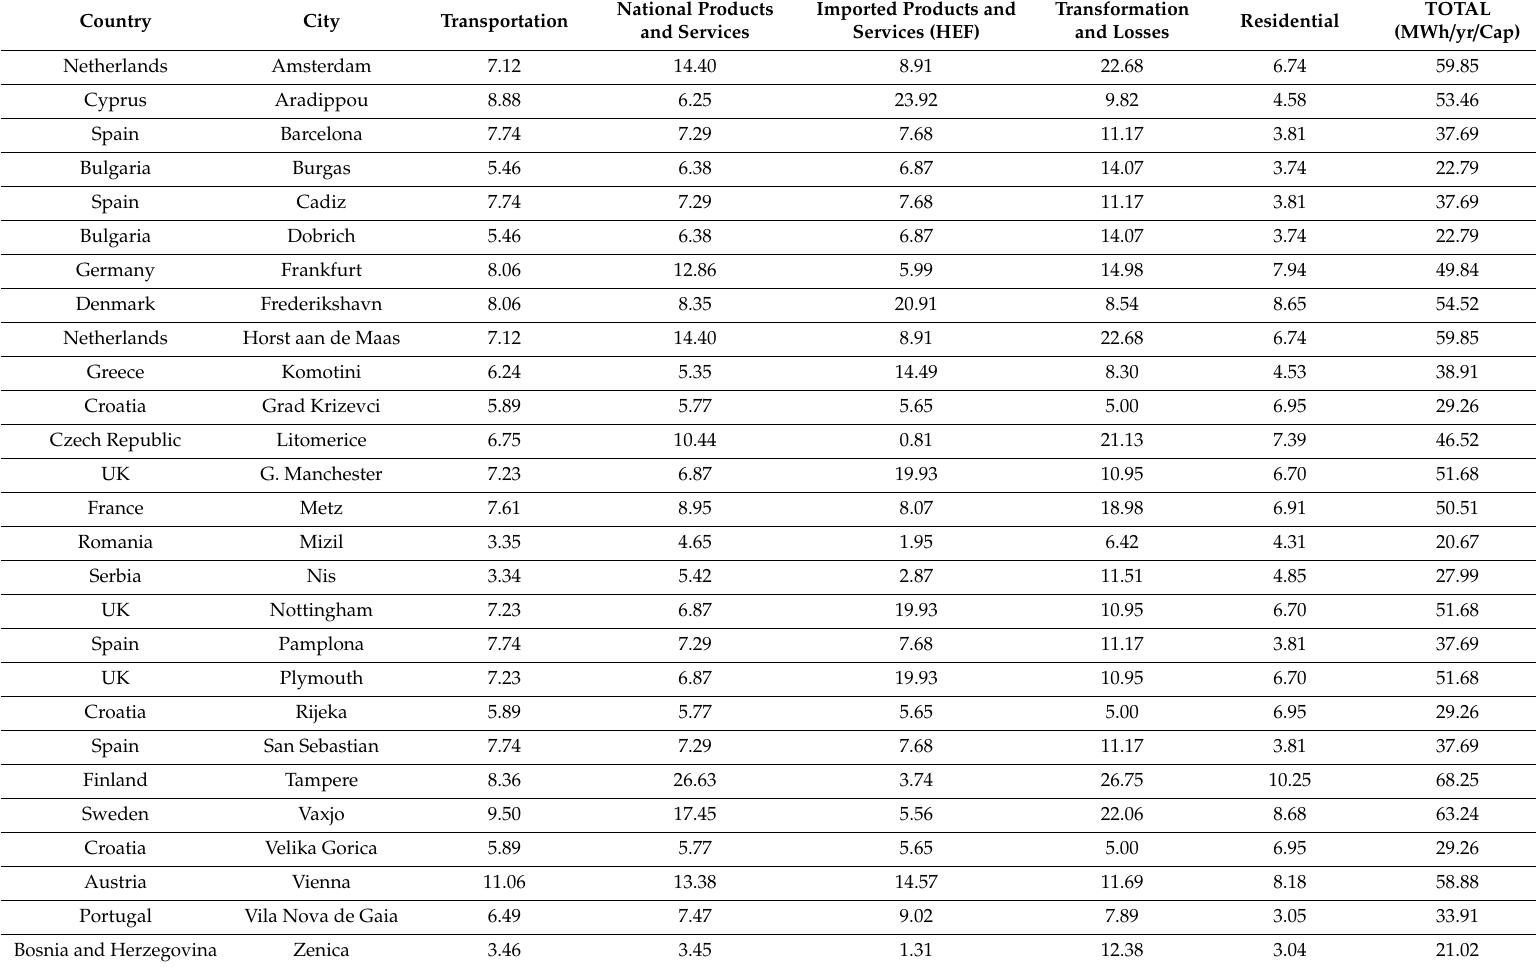
Table A4. National average energy consumption data corresponding to each city. TPES data have been extracted from IEA, while TPEF and HEF data have been calculated by the authors using GMRIO